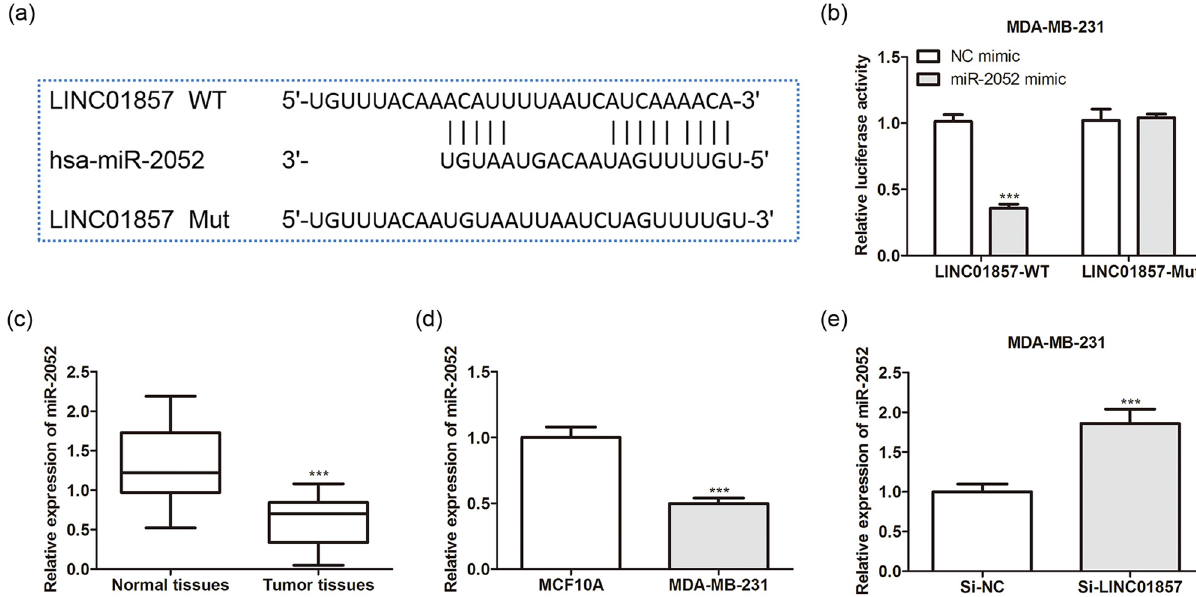
Figure 3: Regulatory relationship between LINC01857 and miR - 2052 in BC: ( a ) the binding sites between LINC0185 and miR - 2052; ( b ) the interaction between LINC0185 and miR - 2052 was evaluated by a dual - luciferase reporter assay. *** P < 0.001 vs NC mimic group. MiR - 2052 levels in BC ( c ) tissues and ( d ) cells were detected by the qRT - PCR assay. *** P < 0.001 vs normal tissues or MCF10A cells. ( e ) MiR - 2052 levels in BC cells transfected with si - LINC01857 were determined by qRT - PCR assay. *** P < 0.001 vs si - NC